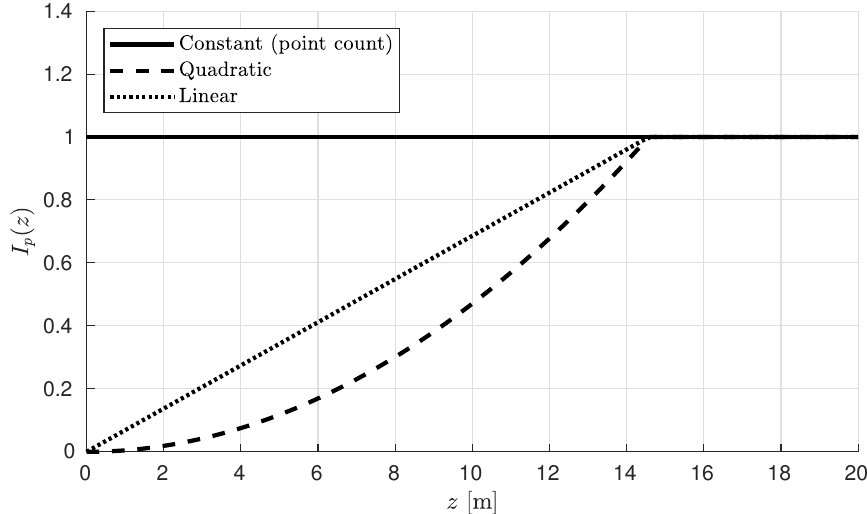
Figure 5. Plot of the point intensities I p ( z ) for the three discussed calculation